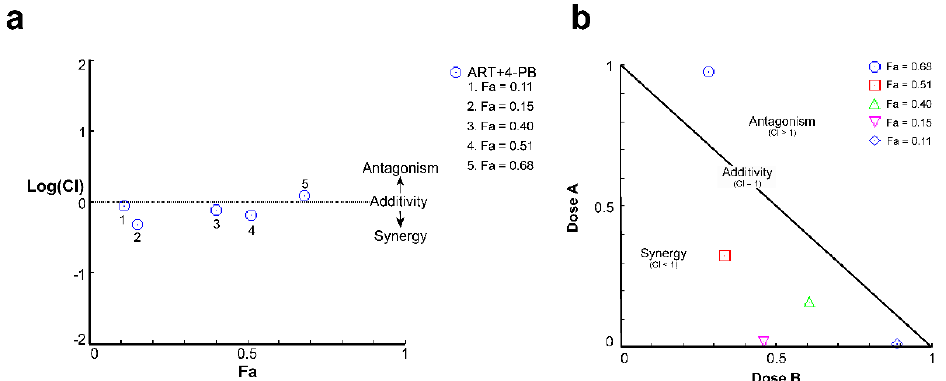
Figure 3. The nature of interaction between 4-PB and ART was analysed using the Median-Effect Principle (Chou) and the Combination Index-Isobologram Theorem (Chou-Talalay). ( a ) CI plot showing substantial synergism at higher Fa values. ( b ) Isobologram showing visual, not quantitative, determination of synergism or antagonism. Combination data points on the isobologram show the nature of interaction with the combination treatment at different Fa.